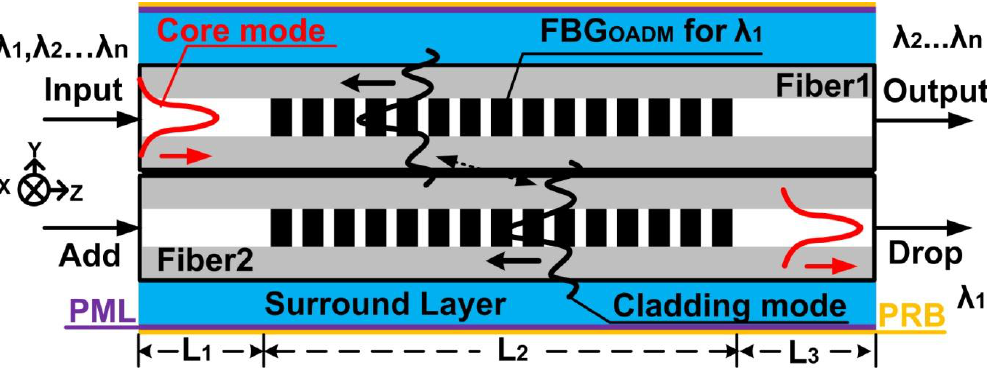
Figure 1. Side view ( X-Z plane) of the proposed FBG-OADM.